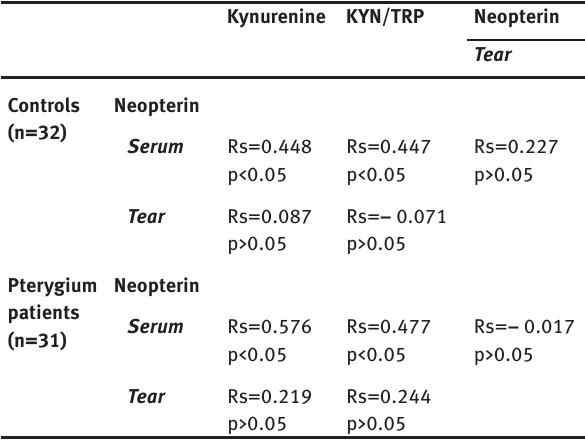
Figure 2: Correlation between kynurenine/tryptophan ratio and neopterin levels in pterygium